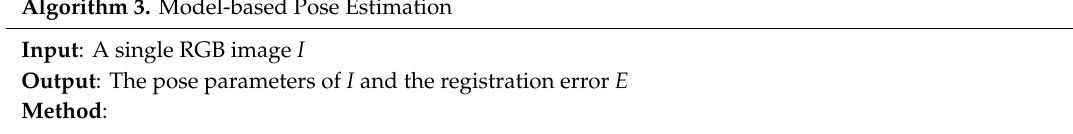
Algorithm 3. Model-based Pose